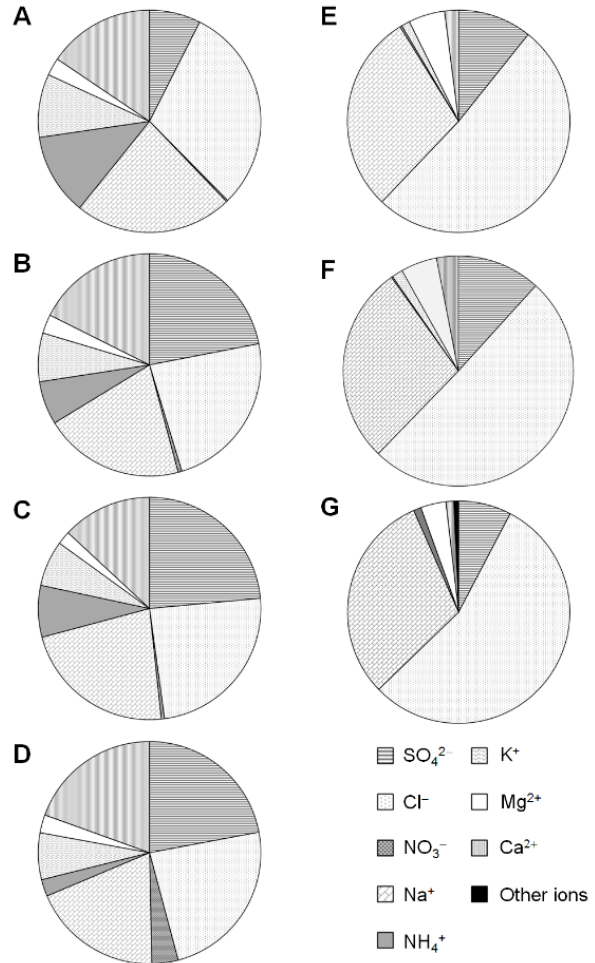
Figure 2. Comparison of ion concentration ratios of Galing River water samples collected upstream ( A : Average ionic concentration ratio of G1a-1 to 6, B : G1b-1 to 2, C : G1c-1 to 4 D : G2-1 to 4) and downstream ( E : Average ionic concentration ratio of G1a-7 to 8, F : G2-5) and sea water ( G : sea water [19]).